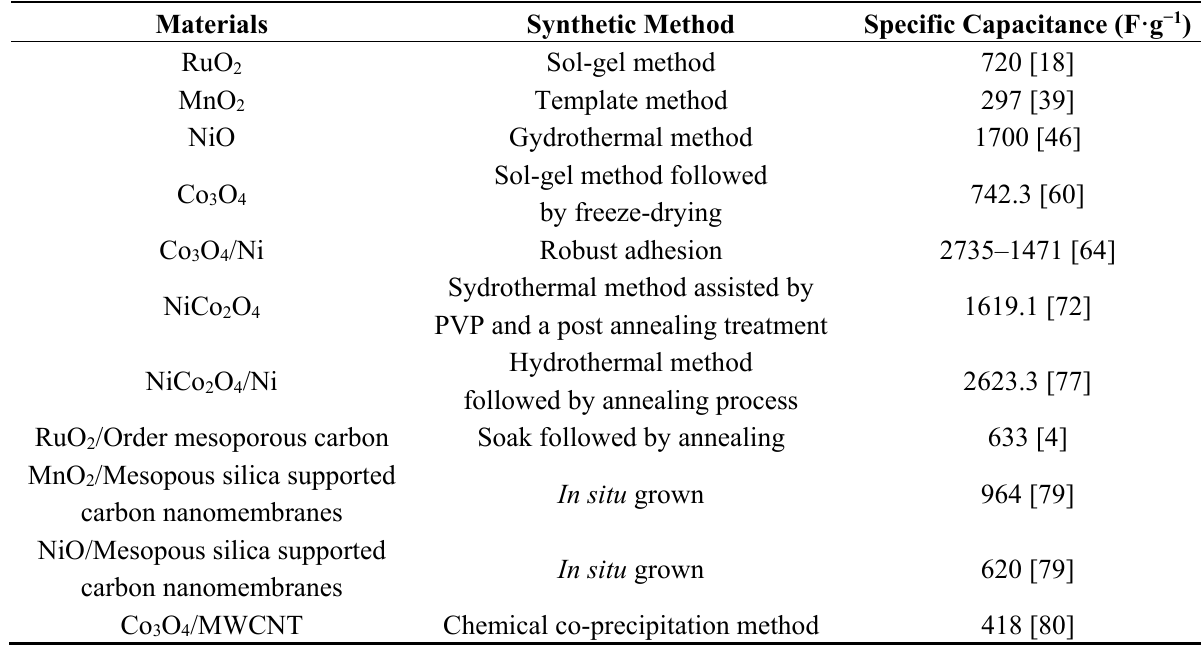
Table 2. The best special capacitances of each